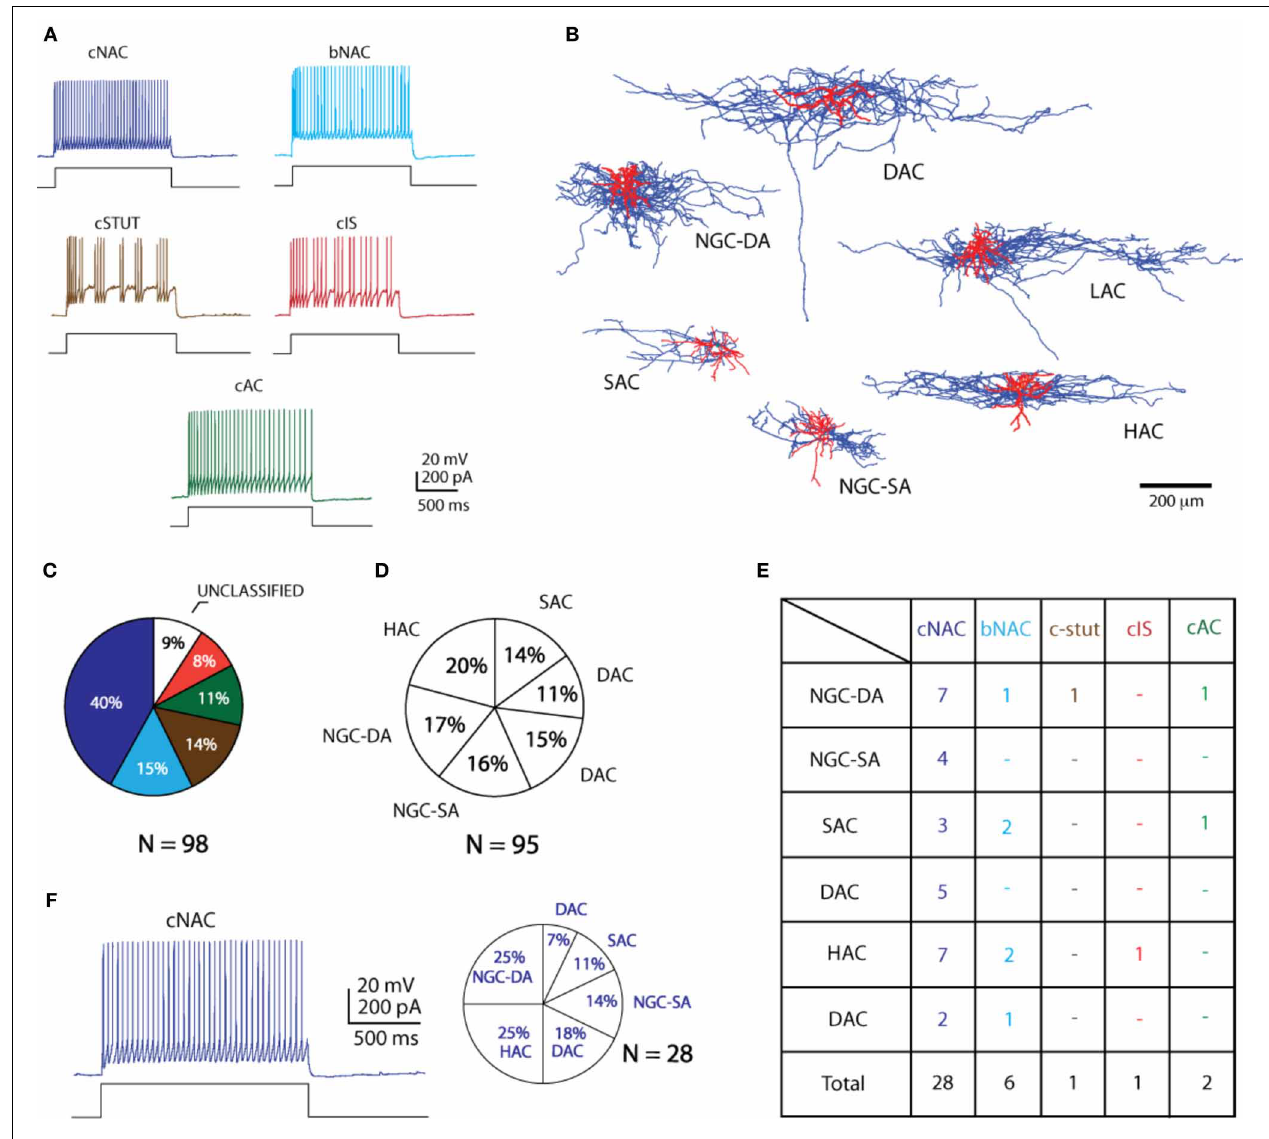
FIGURE 3 | Morpho—electrical types in L1. (A) Summary of all the firing patterns and (B) all the morphological types found in L1 (C) shows the percentage distributions of the electrophysiological subtypes whereas (D) shows the morphological subtypes. Firing